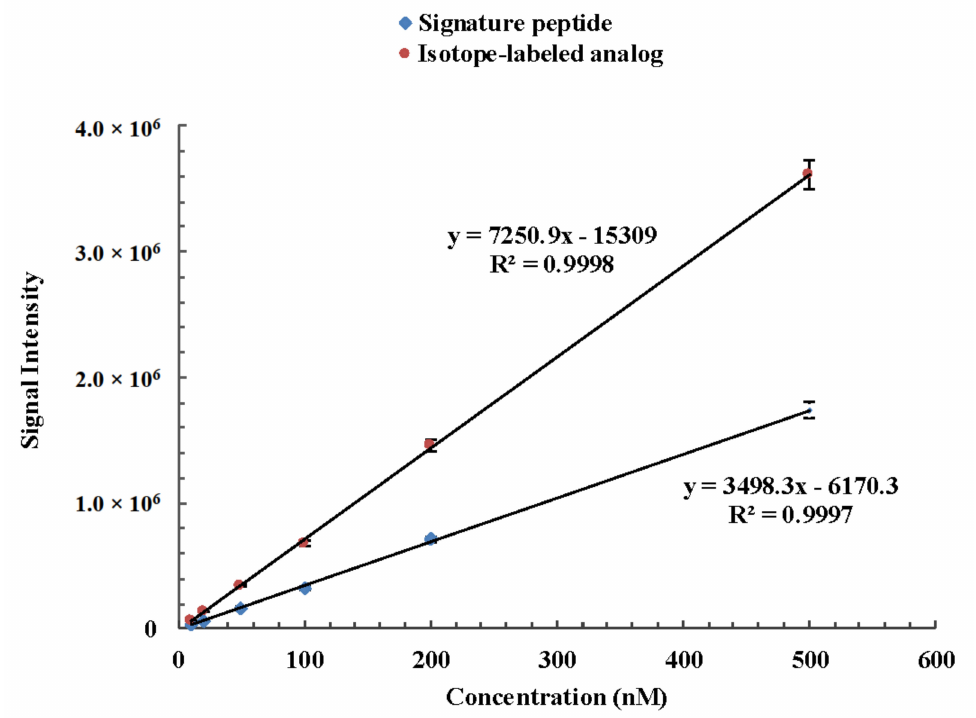
Figure 3. Linear response of camel lactoferrin signature peptide DVTVLDNTDGK and its corresponding isotope-labeled analog DVTVL*DNTDGK during the UHPLC-MS / MS analysis.